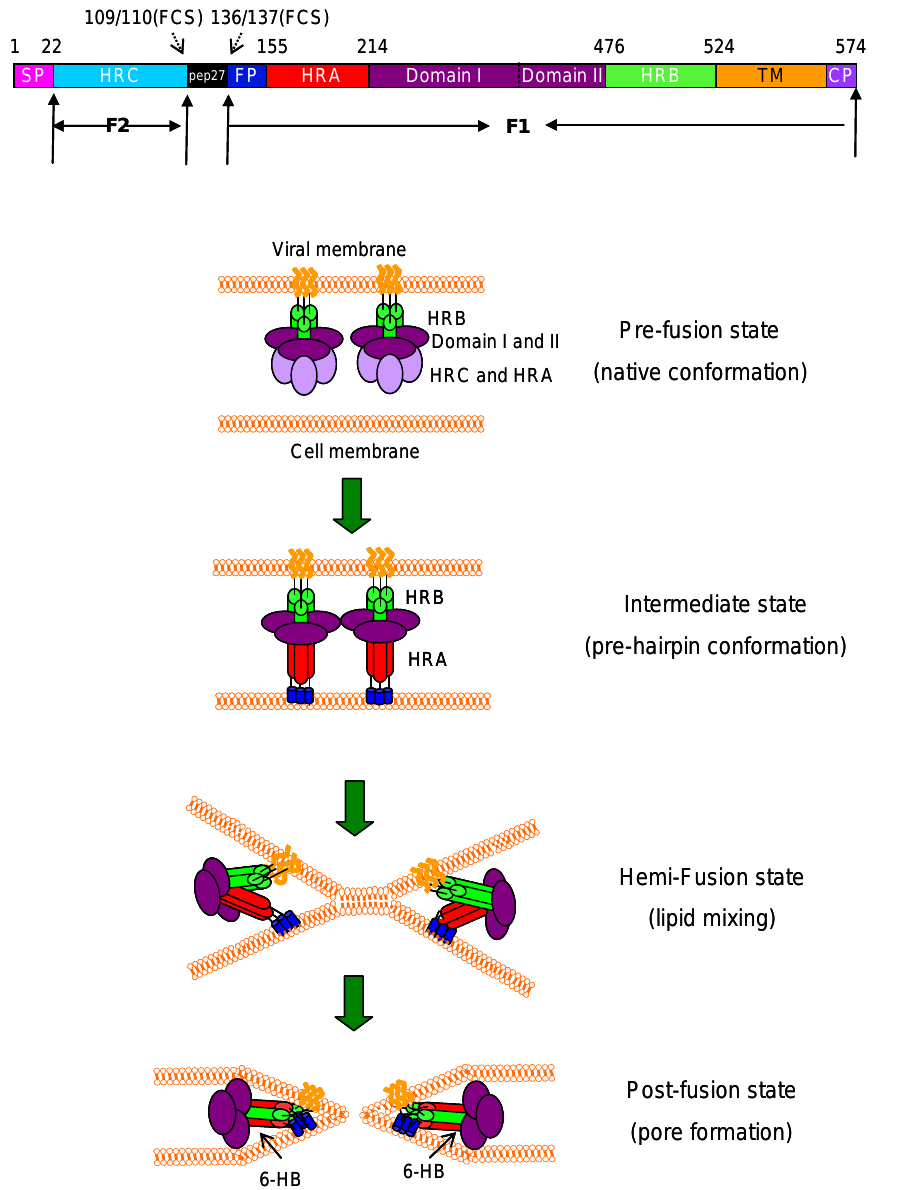
Figure 1. Structure of respiratory syncytial virus (RSV) F protein and RSV fusion/entry processes. ( A ) Schematic representation of RSV F